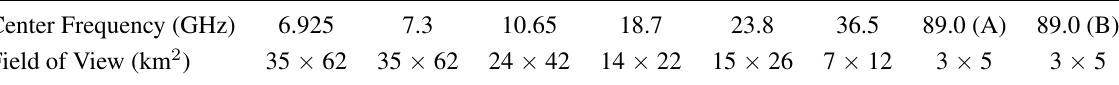
Table 1. Advanced Microwave Scanning Radiometer 2 (AMSR2) footprint sizes at the different frequencies according to the Global Change Observation Mission 1st-Water (GCOM-W1) “SHIZUKU” Data Users Handbook